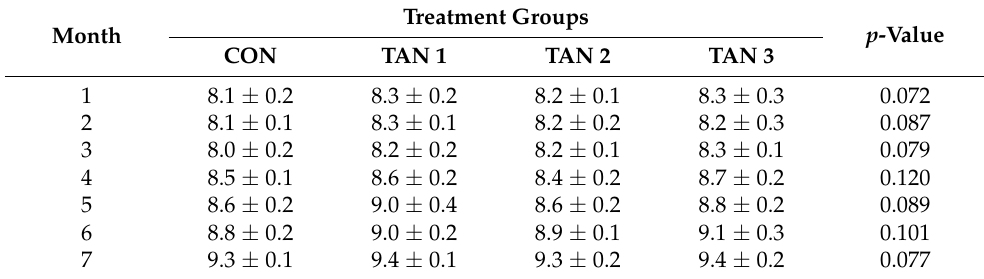
Table 2. Monthly average dry matter intake per pen.